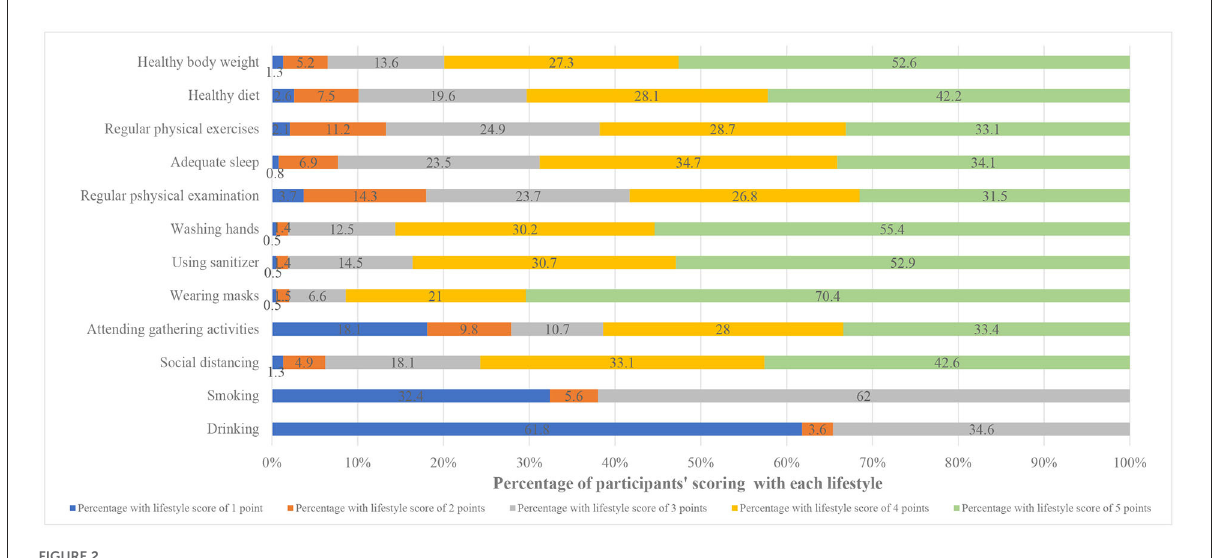
FIGURE2 The overall composition of participants’ scoring by each